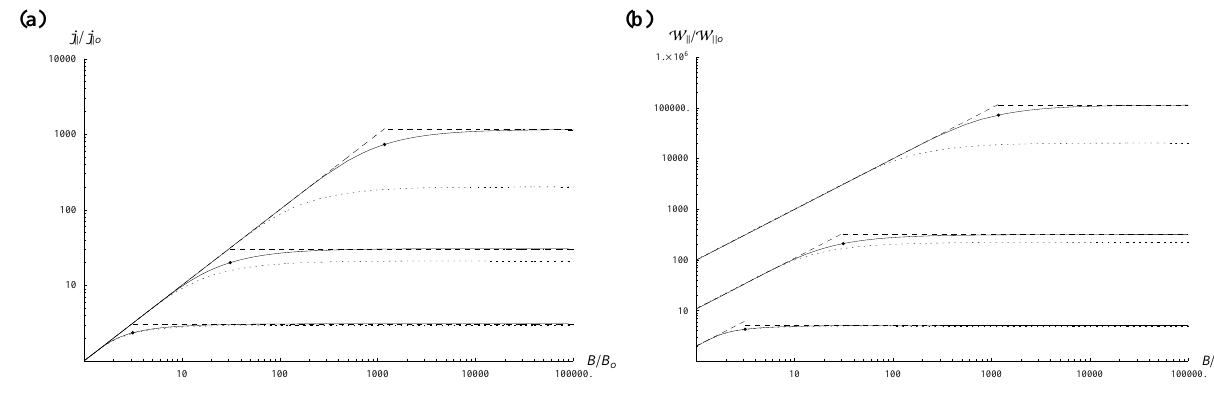
Fig. 2. Plots showing the variation of (a) the normalised field-aligned current density (cid:0) j || (cid:14) j || o (cid:1) (or equivalently the number flux) and (b) the normalised field-aligned kinetic energy flux (cid:0) W || (cid:14) W || o (cid:1) of the accelerated population, versus (cid:0) B (cid:14) B o (cid:1) beneath the voltage drop, for fixed values of the accelerating potential 8 and thermal energy kT of the unaccelerated population. The fluxes are normalized in each case to the (cid:16) . (cid:17) = 20 (corresponding to kT ∼ 25keV mc 2 kT corresponding values for the unaccelerated population, given by Eq. (17). All curves are for for electrons), while the lower, middle, and upper curves in each panel are for (cid:0) e8 (cid:14) kT (cid:1) = 2, 20, and 200 (corresponding to e8 ∼ 50, 500, and (cid:16) . (cid:17) = 0 . 1, 1, and 10. The solid lines in each panel show the relativistic values given e8 mc 2 5000keV for electrons), respectively, such that by Eq. (23) for the current density and Eq. (26) for the kinetic energy flux, while the dotted lines show the non-relativistic approximations given by Eqs. (24) and (27). The dashed lines show the limiting behaviours for small and large (cid:0) B (cid:14) B o (cid:1) , given by Eqs. (28) and (29) for small (cid:0) B (cid:14) B o (cid:1) , and Eqs. (33) and (34) for large (cid:0) B (cid:14) B o (cid:1) . The transition from one dashed line limit to the other has been taken to occur at (cid:0) B (cid:14) B (cid:1) = (cid:0) B (cid:14) B (cid:1) given by Eq. (37), at which point a solid dot is shown on the solid lines, marking the transition between these o o lim A − B limiting